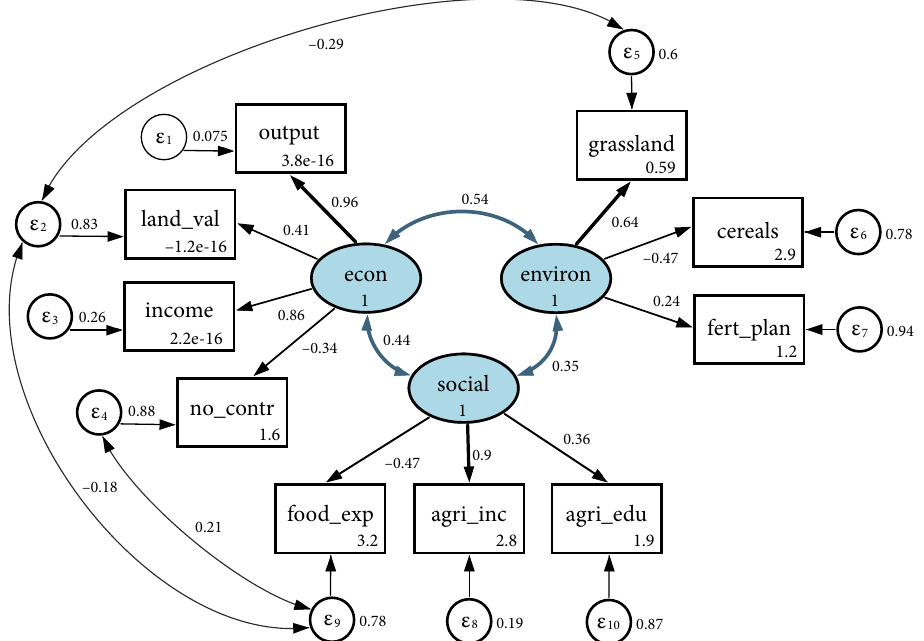
Figure 2. Relationships between economic, social, and environmental dimensions of the operations of farms in the Wielkopolska region, based on structural equation modeling using multiple-factor measurement model with latent